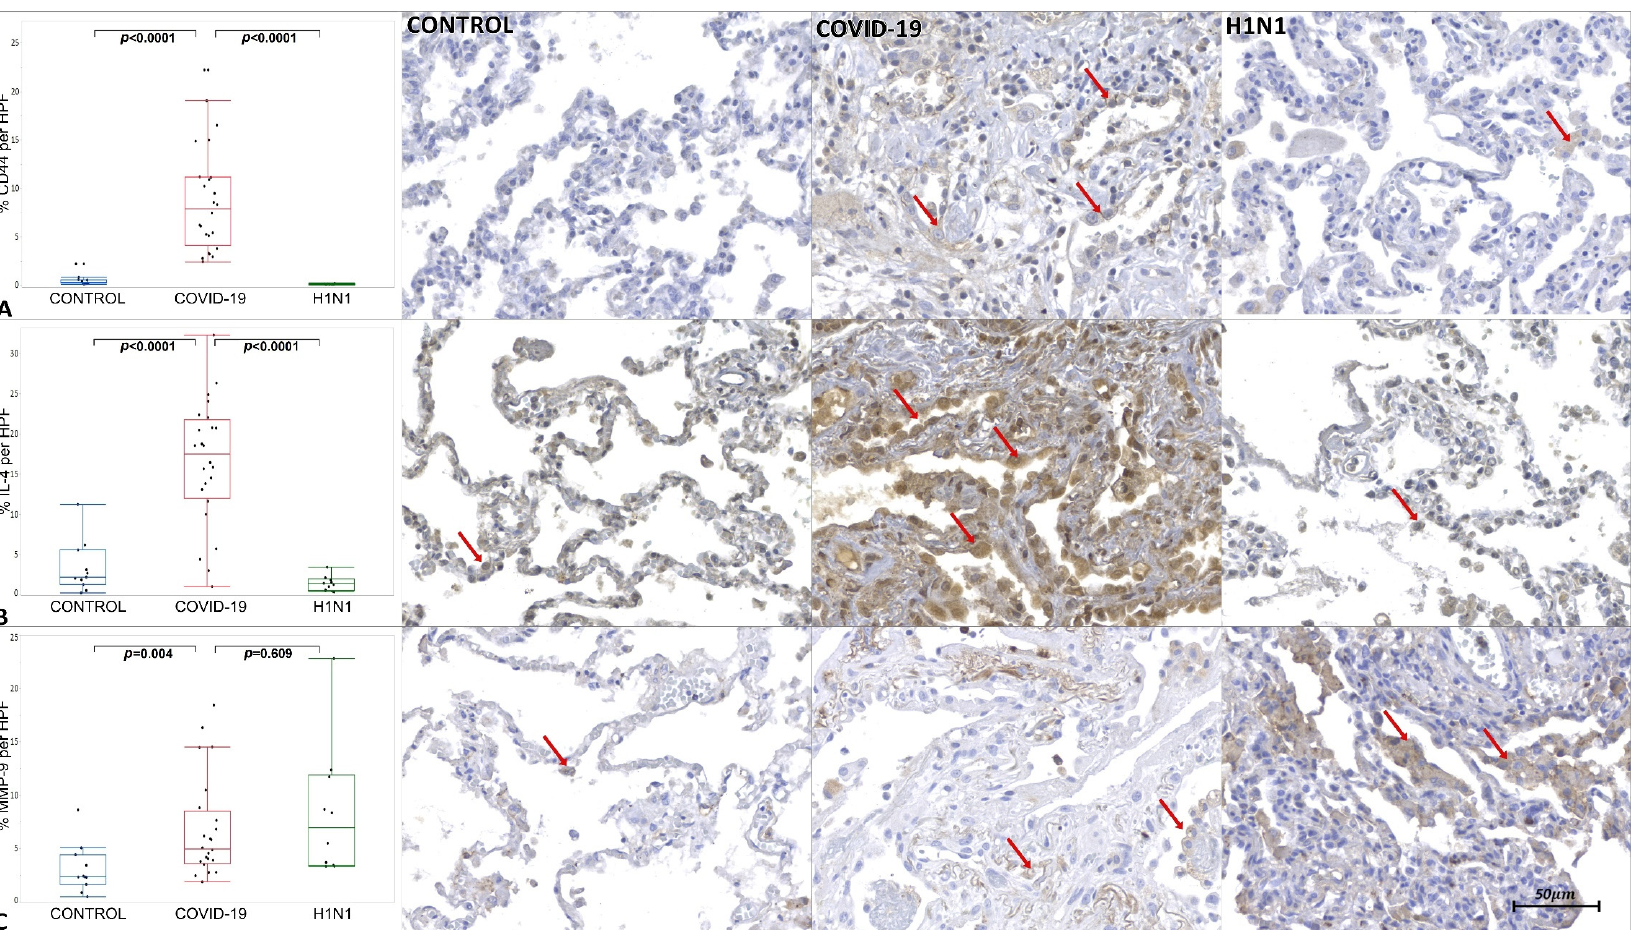
Figure 2. Graphics show tissue immunoexpression of CD44v6, IL-4, and MMP-9 (percentage per HPF). ( A ) Comparative graphs between the CONTROL, COVID-19 and H1N1 groups and photomicrographs of tissue immunoexpression of CD44v6 in alveolar epithelium represented by the red arrow, of the respective groups. ( B ) Comparative graphs between the CONTROL, COVID-19 and H1N1 groups and photomicrographs of tissue immunoexpression of IL-4 in the alveolar epithelium, represented by the red arrow, of the respective groups. ( C ) Comparative graphs between the CONTROL, COVID-19 and H1N1 groups and photomicrographs of tissue immunoexpression of MMP-9 in the alveolar epithelium, represented by the red arrow, of the respective groups.